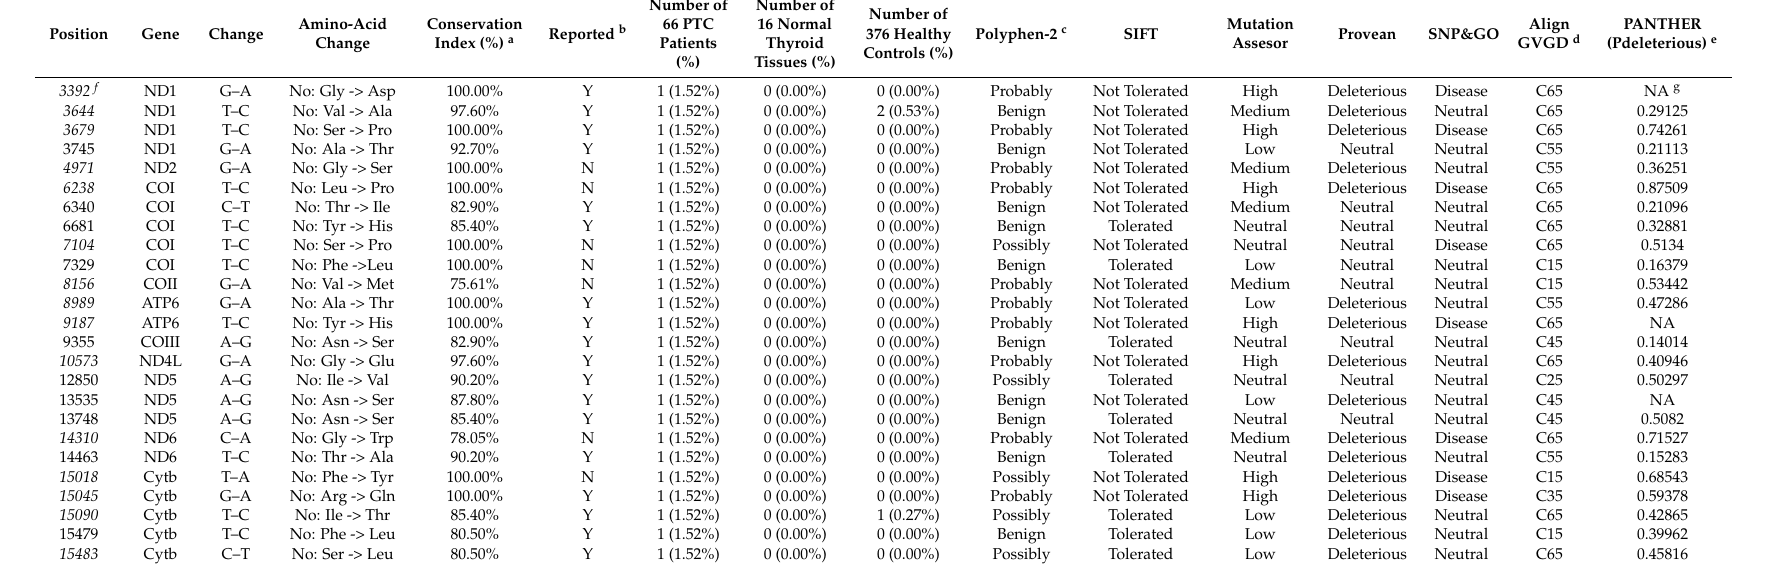
Table 3. Potential pathogenic mtDNA variations identified in protein-coding